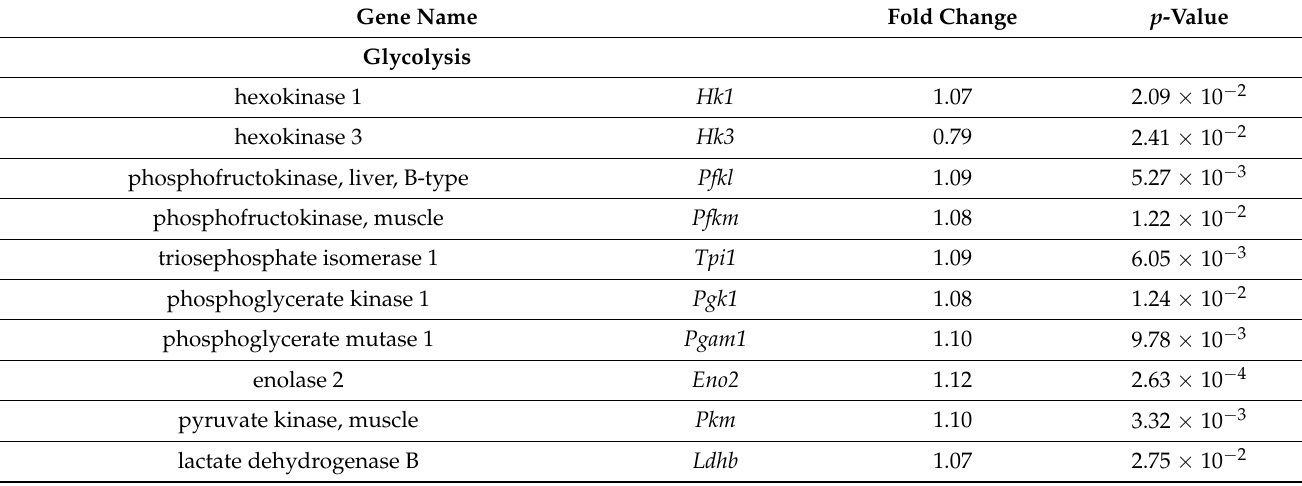
Figure 2. Brain transcriptome analysis. Heatmaps of the genes involved in the mitochondria-associated pathways, regulated in brain of 19-month-old MRPS5 V338Y mutant mice, p -value < 0.05. Please note the different scales for aging and mutation effect. Table 1. Regulated genes related to mitochondria-associated metabolism in 19-month-old MRPS5 V338Y/V338Y mutant compared to wild-type mice.